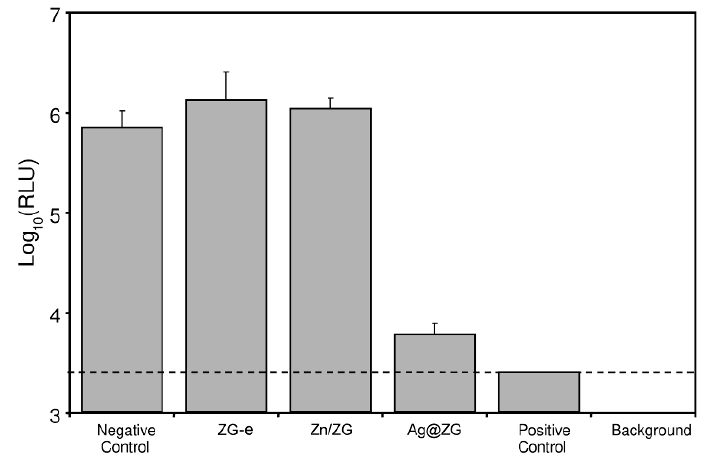
Figure 7. Bioluminescence measurements of the ATP detected in the disks of the different treatments. The bar graph reports the mean value ± S.D. of the measurements expressed as Log10 of relative luminescence values (RLU). For the negative control and the test materials, four different samples were measured. For the positive control the mean refers to two measured values.